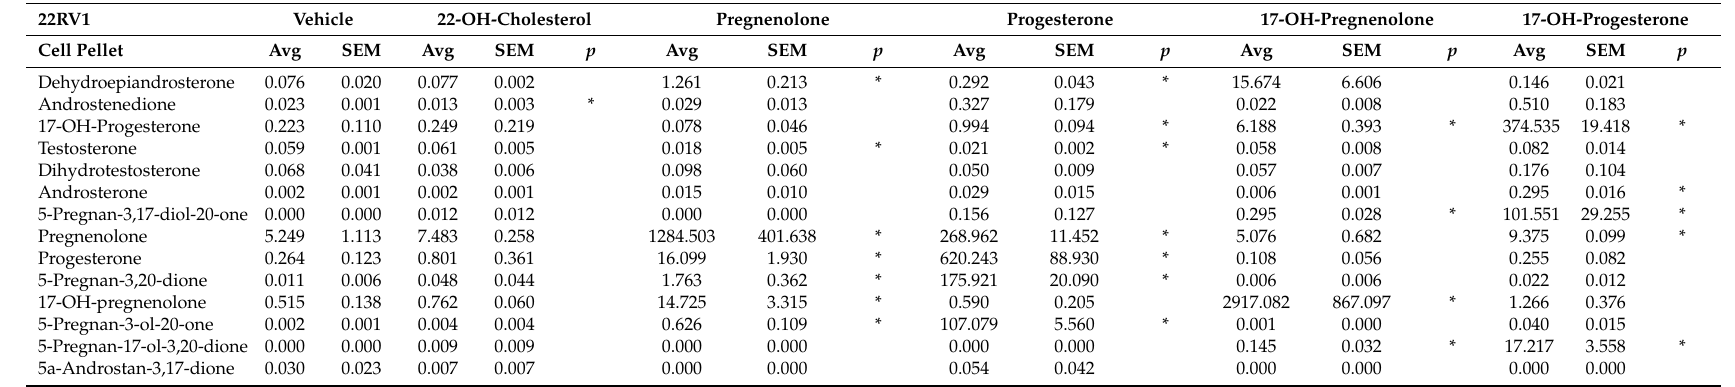
Table 1. Steroid levels (ng/mL) detected in 22Rv1 cells after 48 h of incubation with 2 µ g/mL of 22-OH-cholesterol, pregnenolone, progesterone, 17-OH-pregnenolone, 17-OH-progesterone, or vehicle. * Statistically significant ( p < 0.05) when compared to the vehicle control. Mean ± standard error of the mean (SEM) values were obtained from three separate experiments performed on different days.